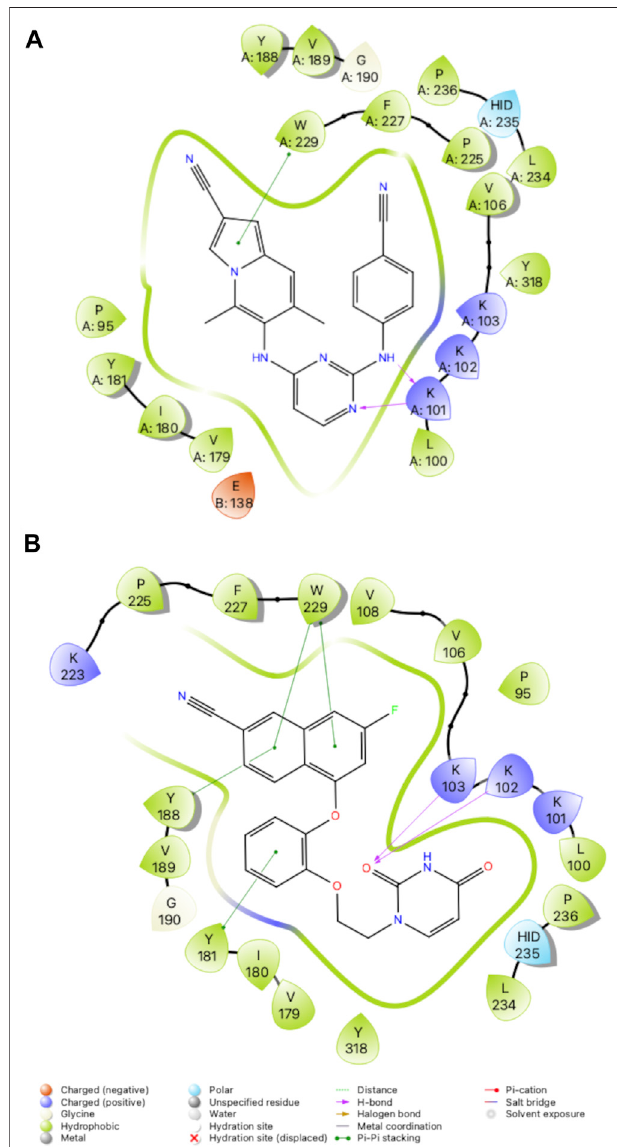
FIGURE5| 2DInteractiondiagramsforRTcomplexeswithcompound 4 (A) and compound 3 (B) . Hydrogen bonds are represented by purple arrows; π - π interactions are represented by green lines between aromatic rings and residues; van der Waals contacts are made between all listed residues within a radius of 4 Å. The key provided below speci fi es residue type, water molecules, and